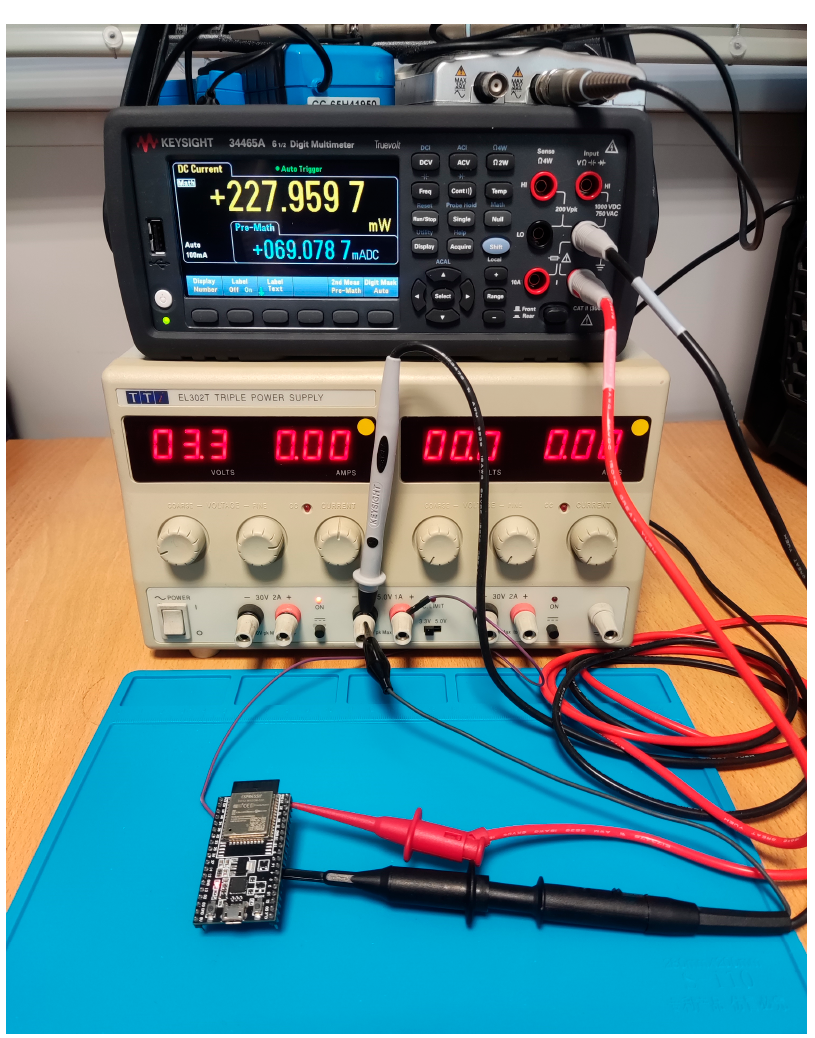
Figure 1. Keysight 34465A DMM and Bench PSU.